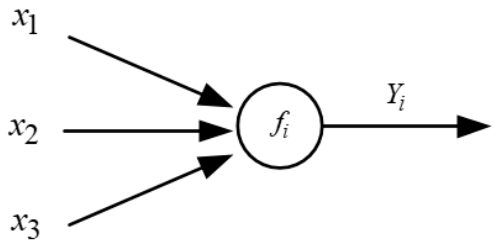
Figure 2. Structure of a GMDH network.